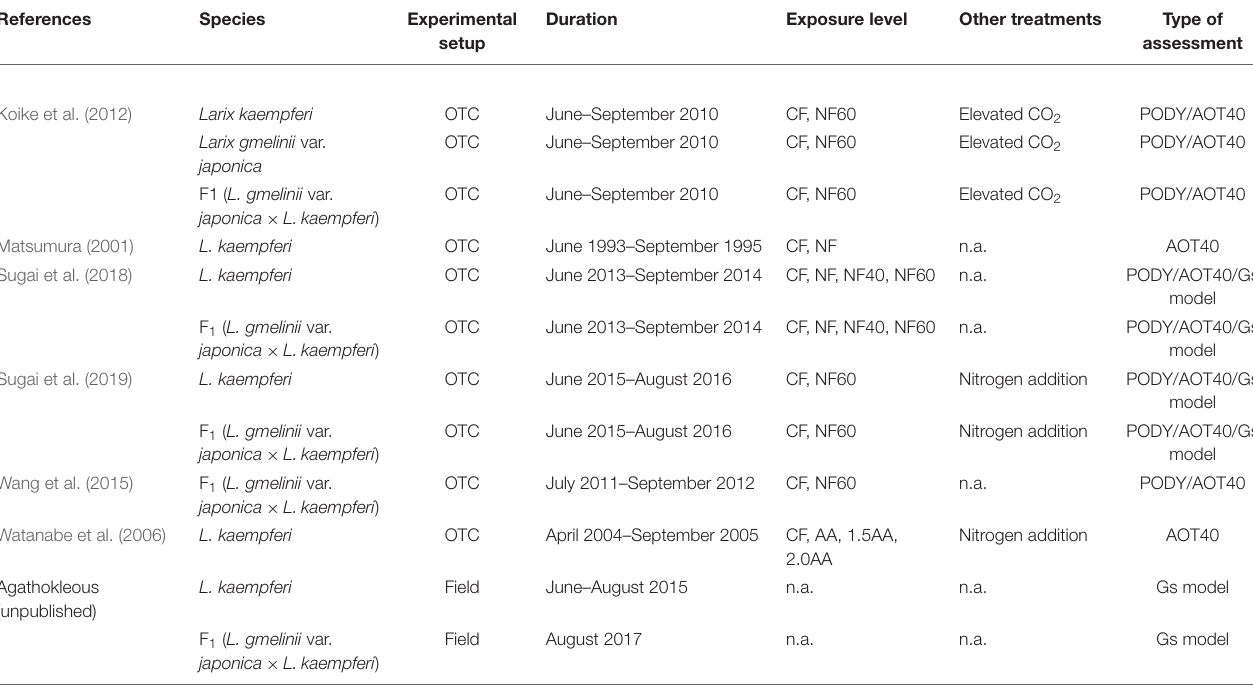
TABLE 1 | Details of experiments from which data were obtained for the analysis (PODY, AOT40, and Gs